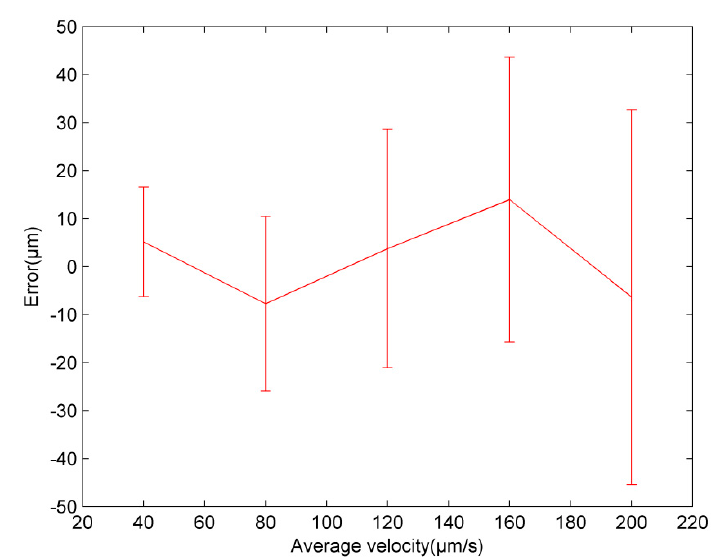
Figure 5. Error and standard deviation at different average velocities (after the vibration compensation).